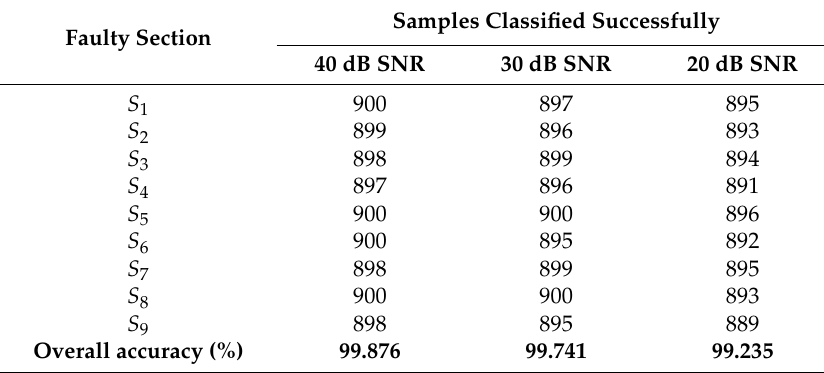
Table 12. Faulty section identification results under noisy